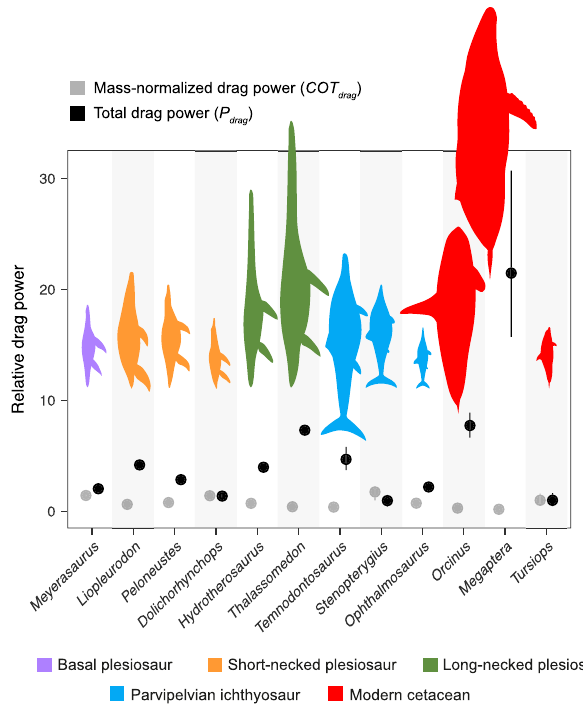
Fig. 3 Comparative plot of mass-normalised drag power and total drag power. Values of mass-normalised drag power (i.e., drag per unit of volume or COT drag calculated as in Fig. 2b) in grey, and non-mass-normalised total drag power, in black, for an array of derived plesiosaurs, parvipelvian ichthyosaurs and modern cetaceans compared at the same inlet velocity of 1 ms − 1 . Error bars represent minimum and maximum values accounting for taxon body size variation (see Supplementary Data). Values are normalised to the results for Tursiops